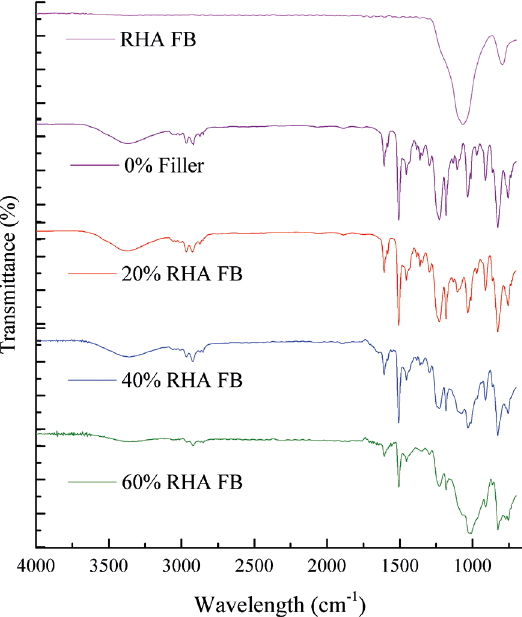
Figure 4. FTIR spectrum for the mixtures prepared with 20, 40, and 60% (wt) RHA-FB